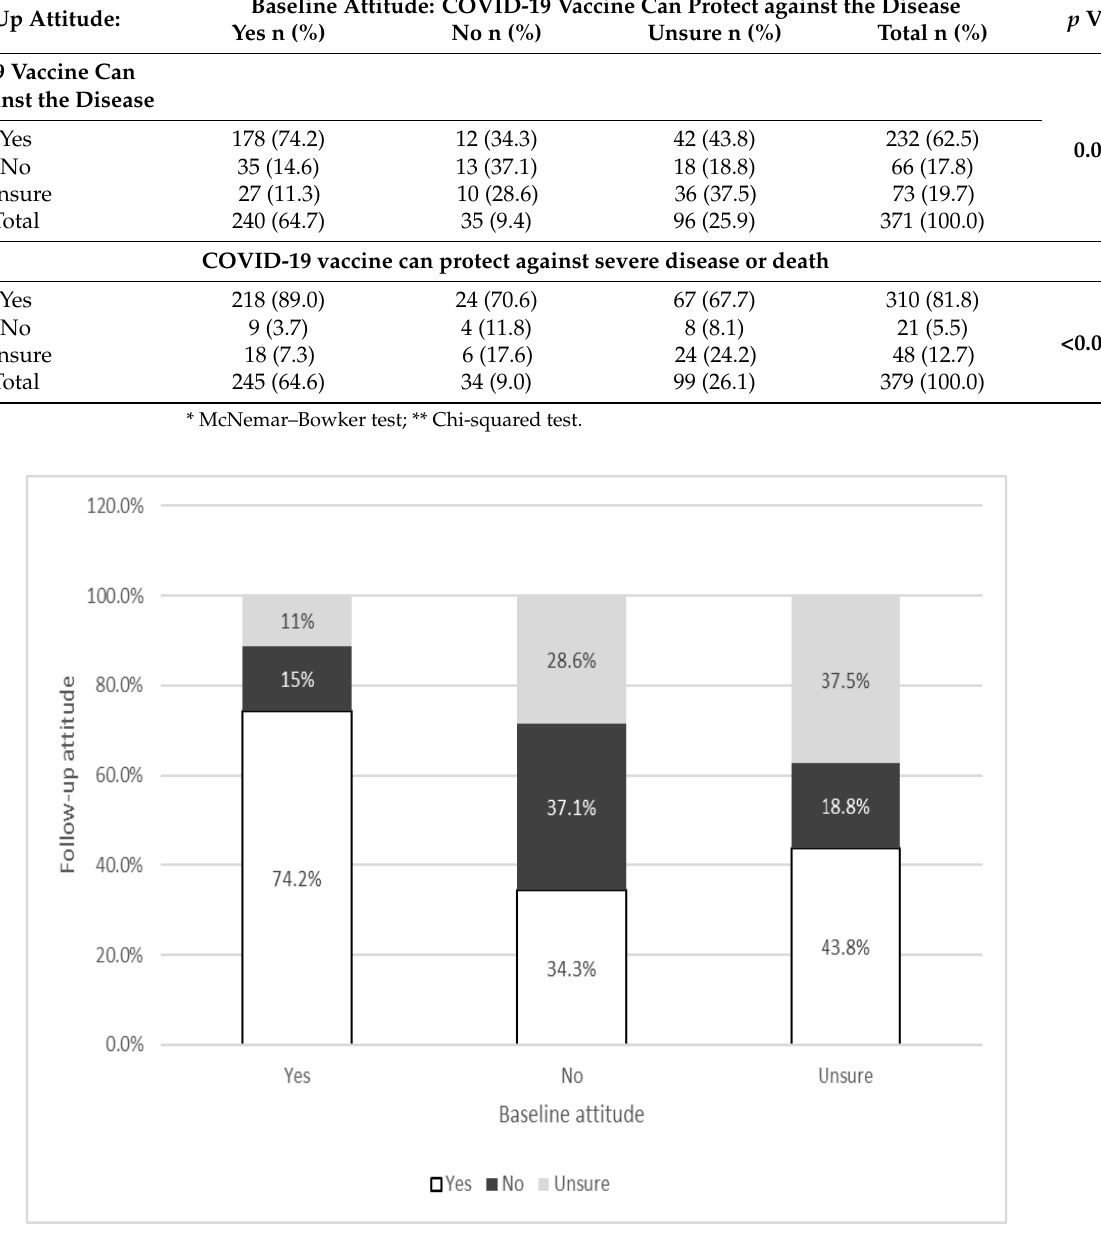
Figure 1. Changes in attitudes toward COVID-19 vaccine protection: baseline and follow-up attitudes (“COVID -19 vaccine can protect against the disease”) .